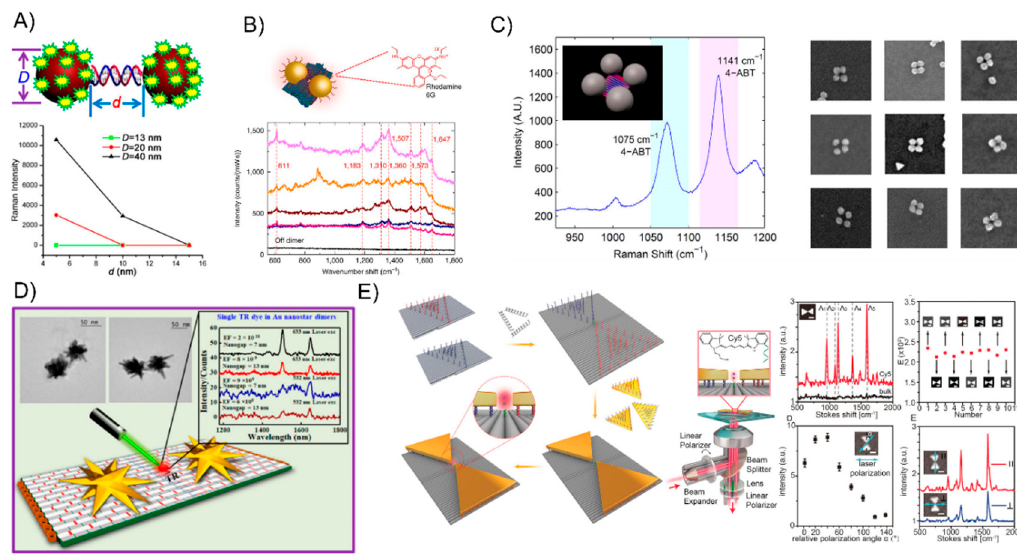
Figure 9. The surface-enhanced Raman scattering of DNA-directed AuNP nanoarchitectures. ( A ) The DNA linker-directed self-assembly of AuNP dimers for investigating the particle size- and interparticle distance-dependency of the ensemble SERS properties. ( B ) The accurate positioning of a 40-nm AuNP with strong plasmonic coupling from reliable 3.3 ± 1.0 nm gaps results in local field enhancements factors of up to seven orders of magnitude. ( C ) Raman-activate molecules